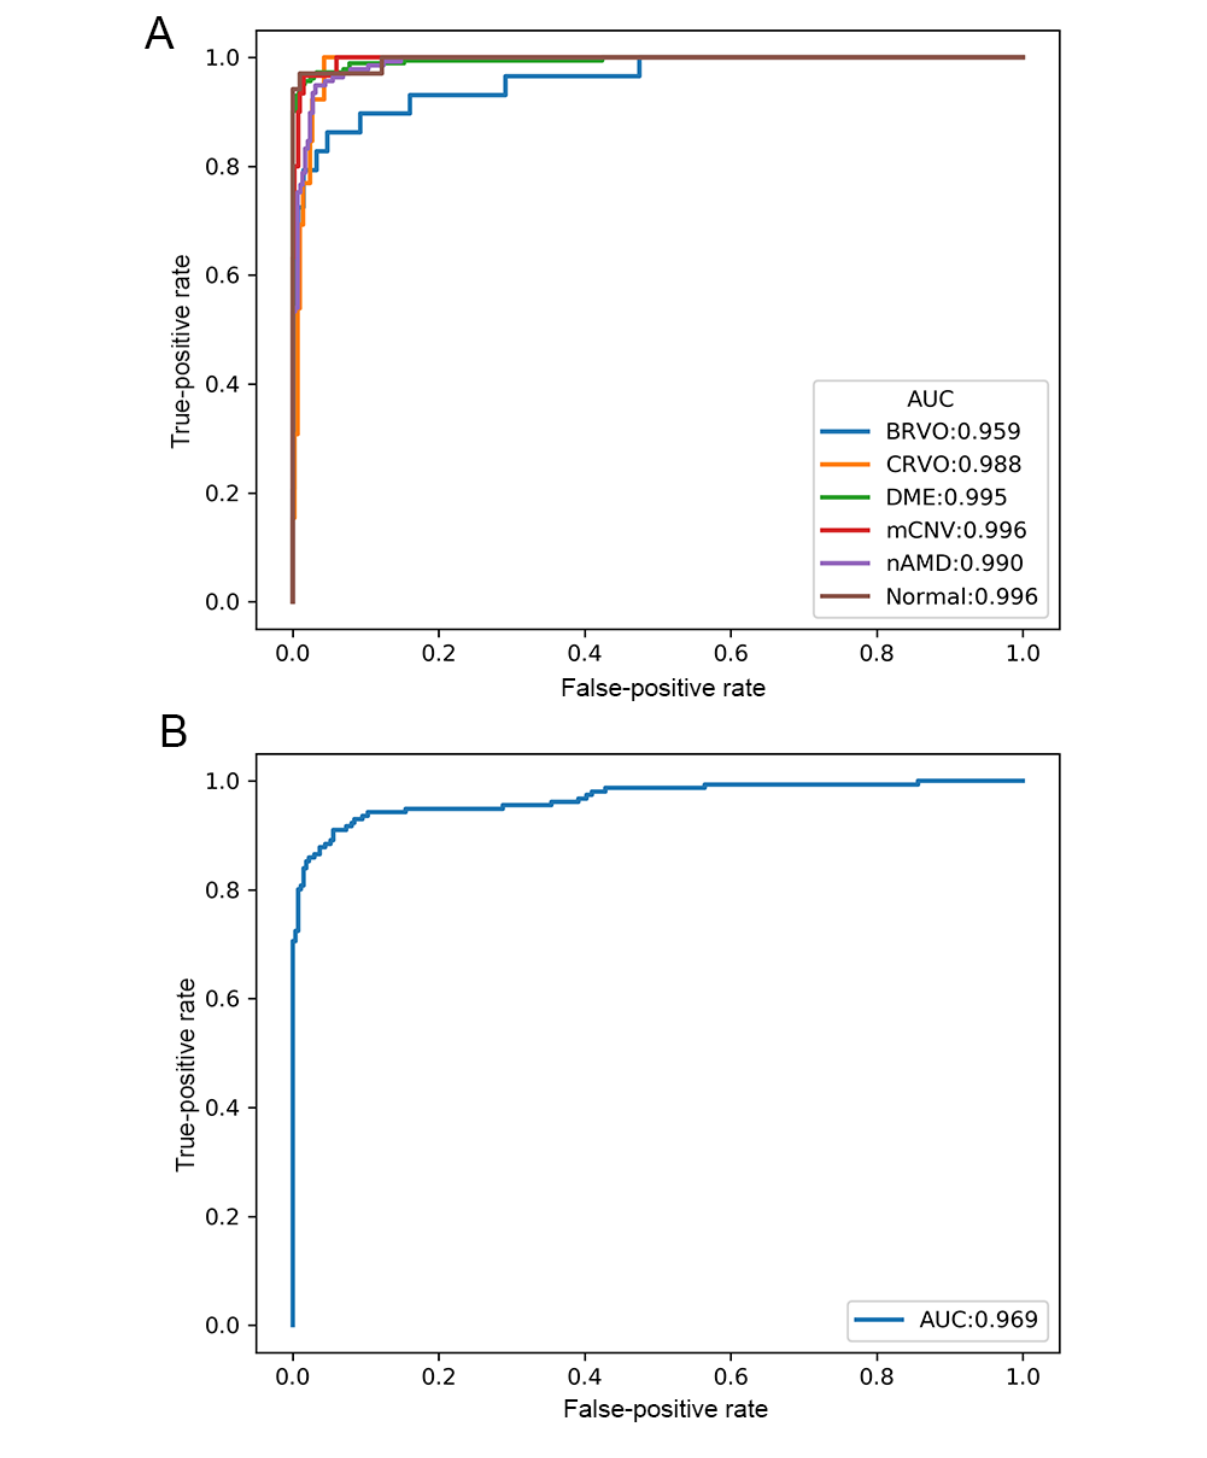
Figure 3. Receiver operating characteristic curves of the model performance for (A) predicting different retinal vascular diseases and (B) identifying treatment-requiring diseases. AUC: area under the curve; BRVO: branch retinal vein occlusion; CRVO: central retinal vein occlusion; DME: diabetic macular edema; mCNV: myopic choroidal neovascularization; nAMD: neovascular age-related macular